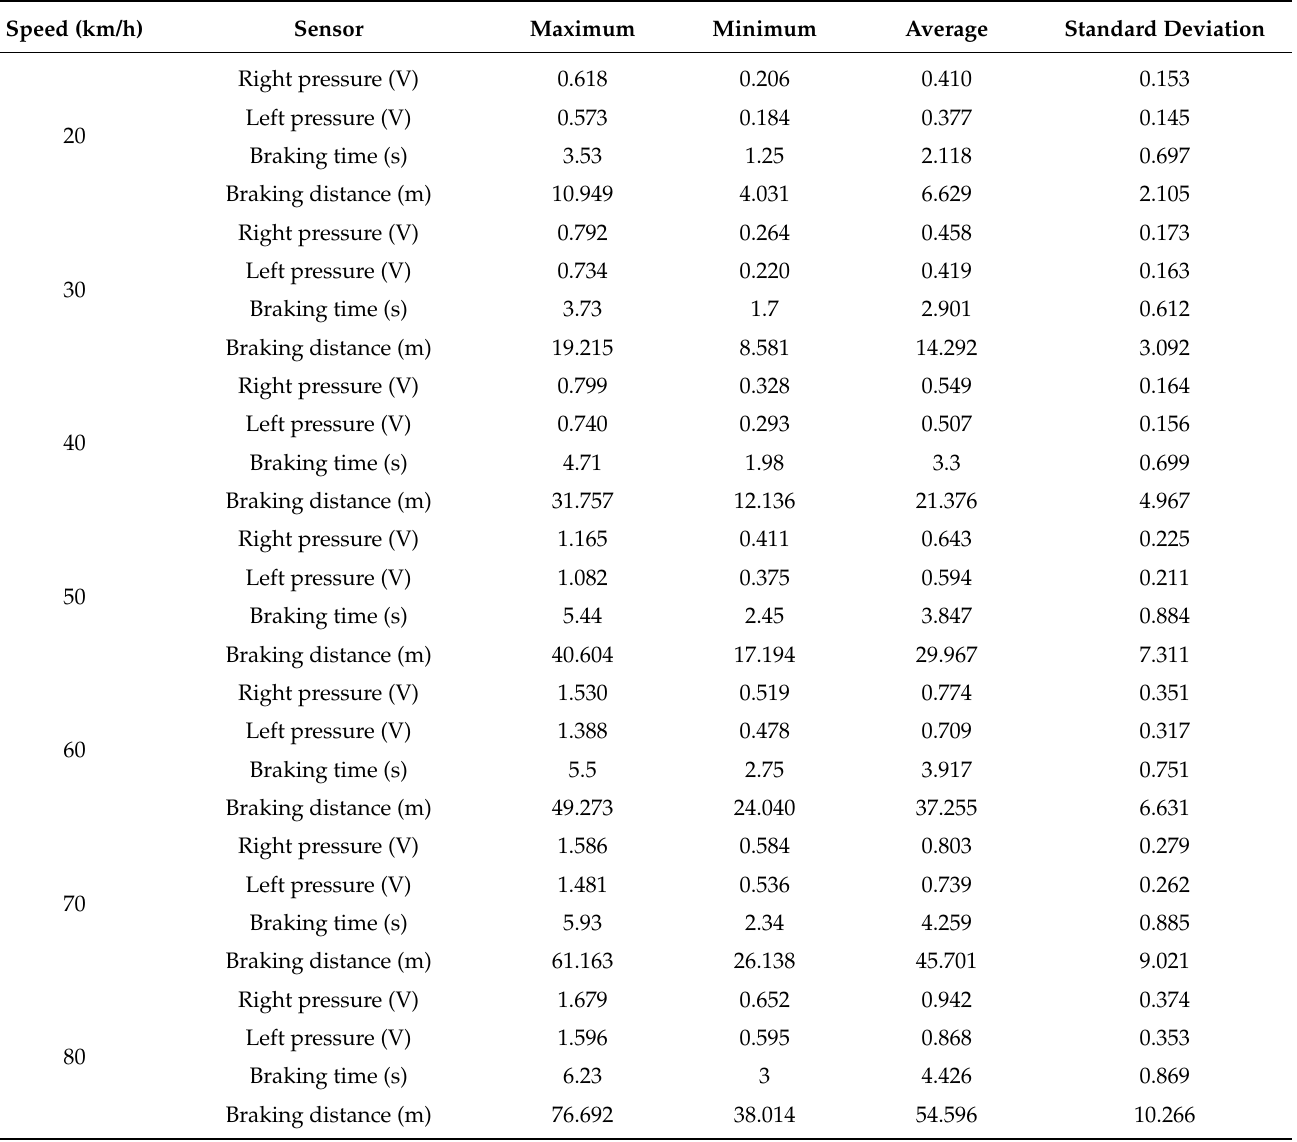
Table 2. Data from variables analysed for each test speed for maintained